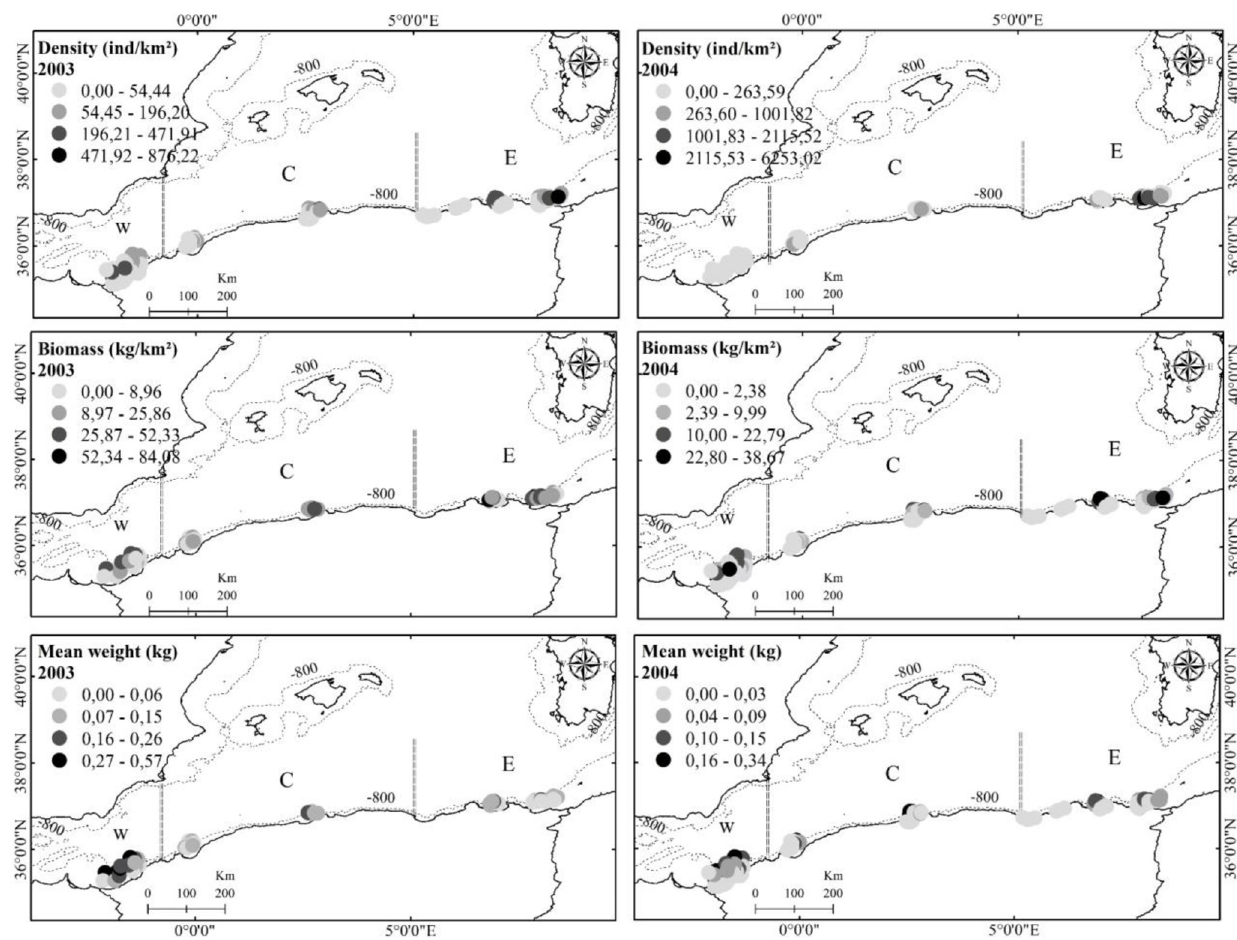
Fig. 4. Mapping density, biomass and mean-weight of P. blennoides caught by BTS (W: west, C: center, E: east).